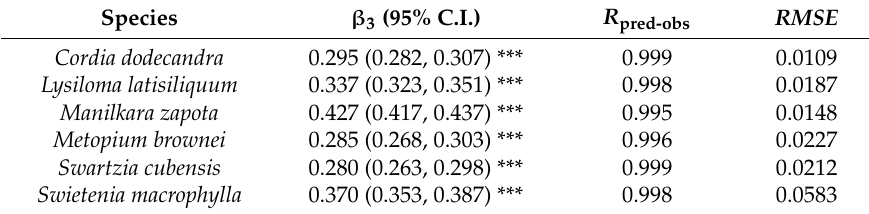
Table 3. Nonlinear models predicting wood volume based on the total volume (Equation (4)).